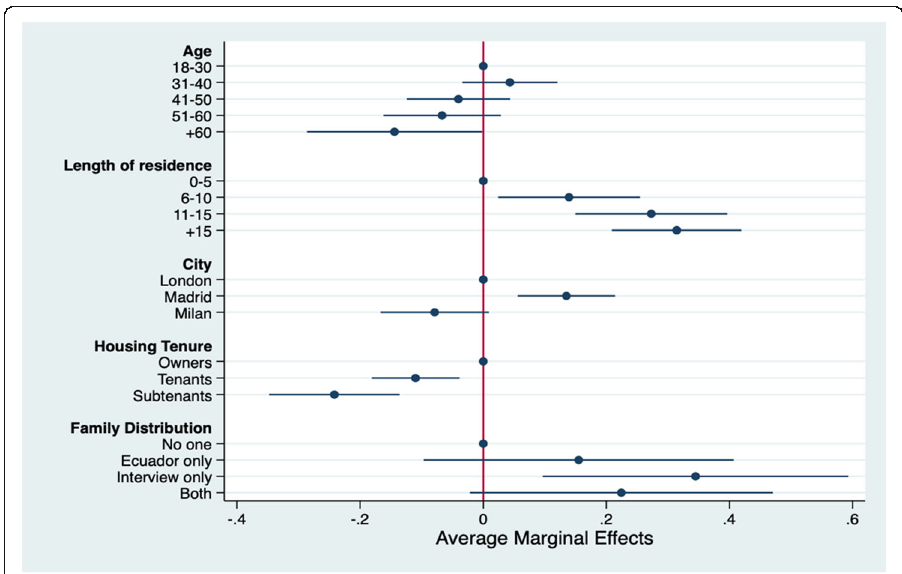
Fig. 2 Average marginal effects of independent variables on the probability to call a place in the country of